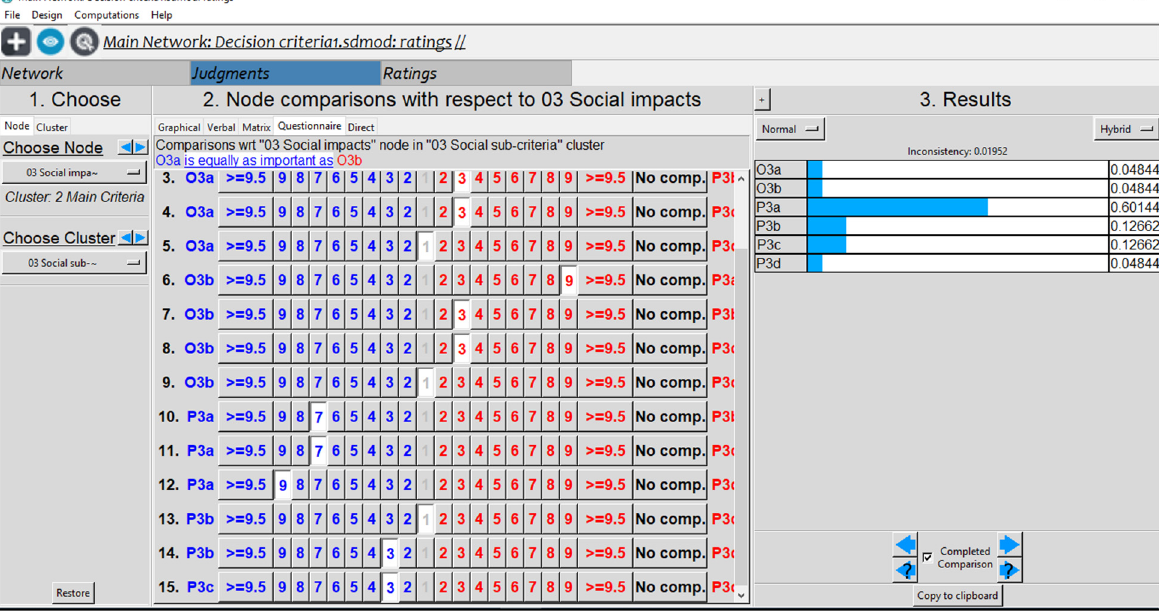
Figure A2. A sample of the pairwise comparison matrix for social impacts sub-criteria.